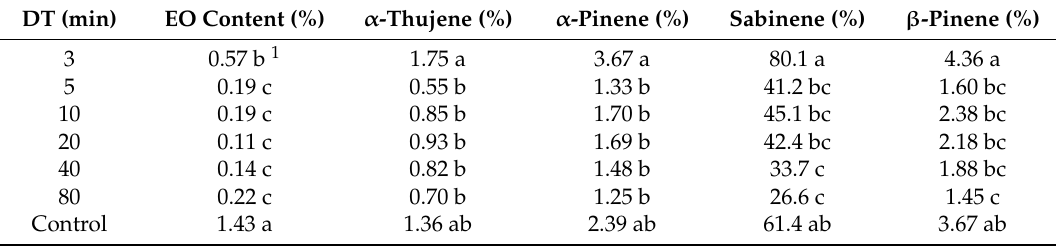
Figure 3. Plot of Distillation time vs. the essential oil (EO) content and the concentrations of 7 constituents along with the fitted Power (convex) and Asymptotic (convex) nonlinear regression models for Juniperus sabina . The fitted models are: ˆ Y = 0.89 DT − 0.59 (EO content), ˆ Y = 1.64 DT − 0.22 ( α -thujene), ˆ Y = 4.0 DT − 0.31 ( α -pinene), ˆ Y = 94.8 DT − 0.3 (Sabinene), ˆ Y = 4.67 DT − 0.28 ( β -pinene), ˆ Y = 2.38 DT − 0.11 (limonene), ˆ Y = 5.16 − 36.3 ( Exp ( − 0.696 DT )) (Terpinen-4-ol), and ˆ Y = 9.94 − 10.3 ( Exp ( − 0.087 DT )) (Methyl Eugenol).